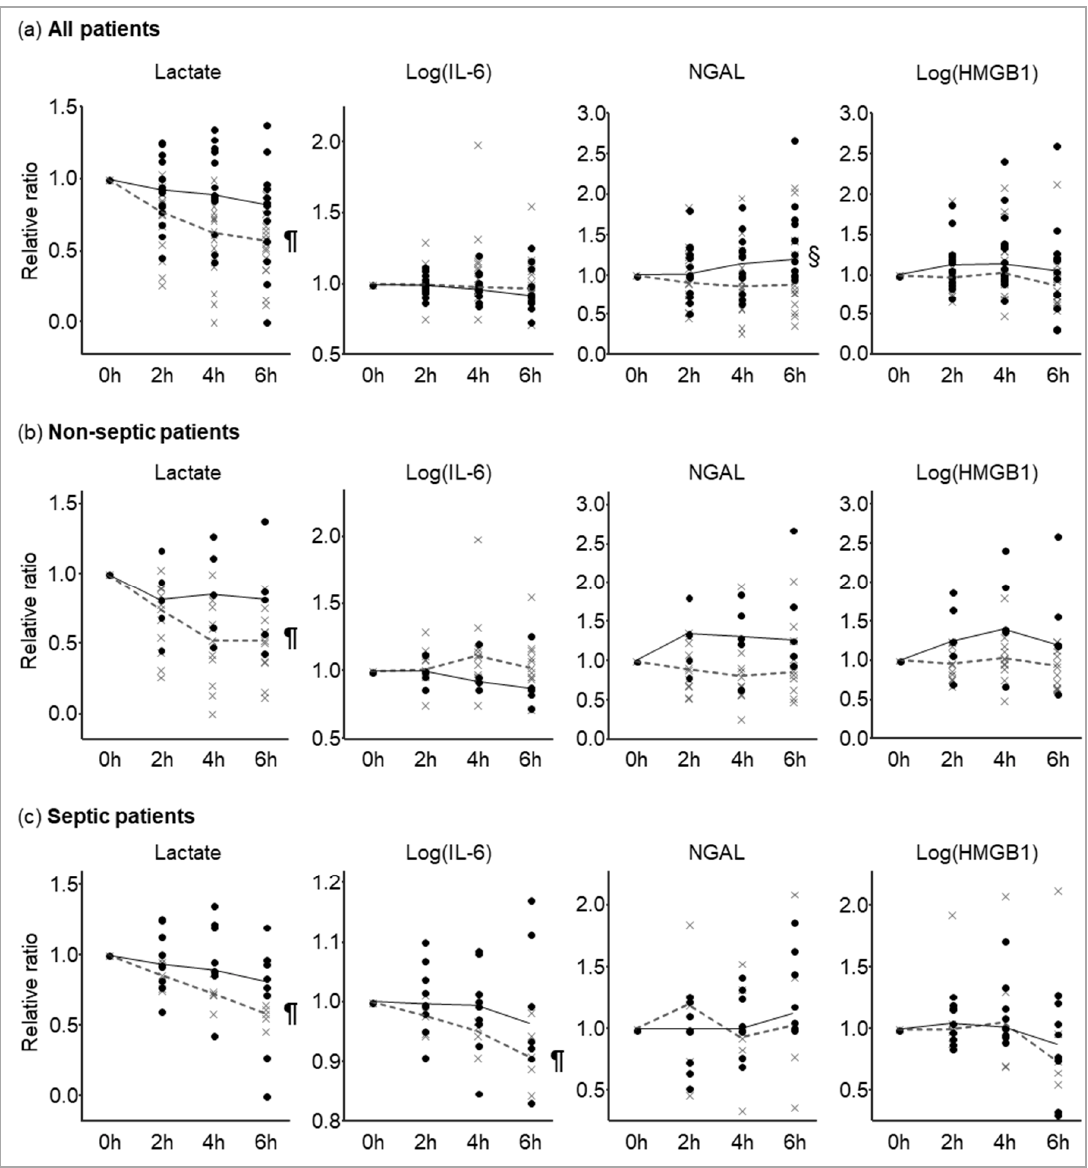
Figure 2. Lactate, IL-6, NGAL, and HMGB1 kinetics in ( a ) all patients, ( b ) patients without sepsis, and ( c ) patients with sepsis. Solid lines and black circles indicate non-survivors; dashed line and gray x-marks indicate ICU survivors. Solid and dashed lines connect the median at each time. ¶: p < 0.05 compared with 0 h in survivors. §: p < 0.05 compared with 0 h in non-survivors.